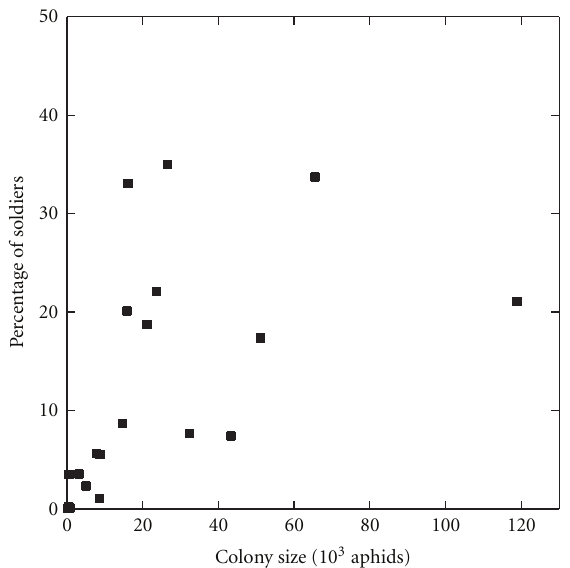
Figure 13: Relationship between colony size and the percentage of soldiers in Pseudoregma bambucicola on Bambusa multiplex . Data for 20 colonies sampled in Kagoshima and Miyazaki Prefectures, Japan, from October to December are shown (drawn from data in [97]). The correlation coe ffi cient is 0.63 after arcsin square-root transformation of the percentage